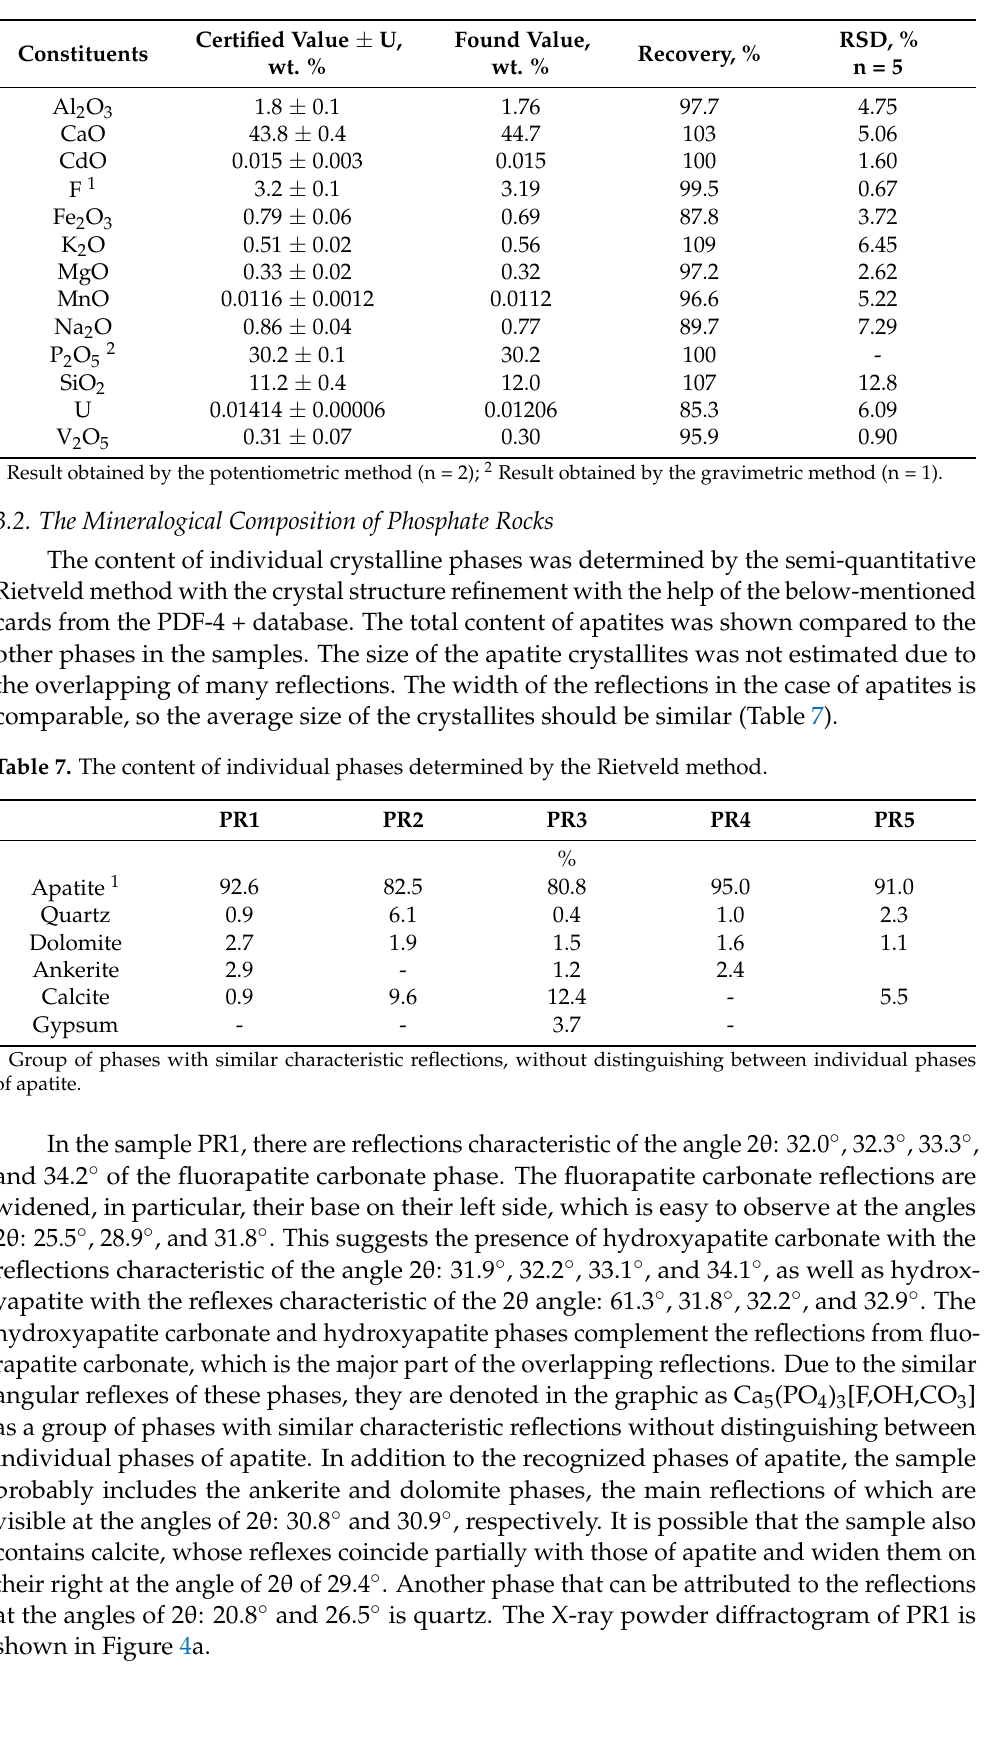
Table 6. Analytical results obtained for SRM 694 by the ICP-OES method and their comparison with the certified values.